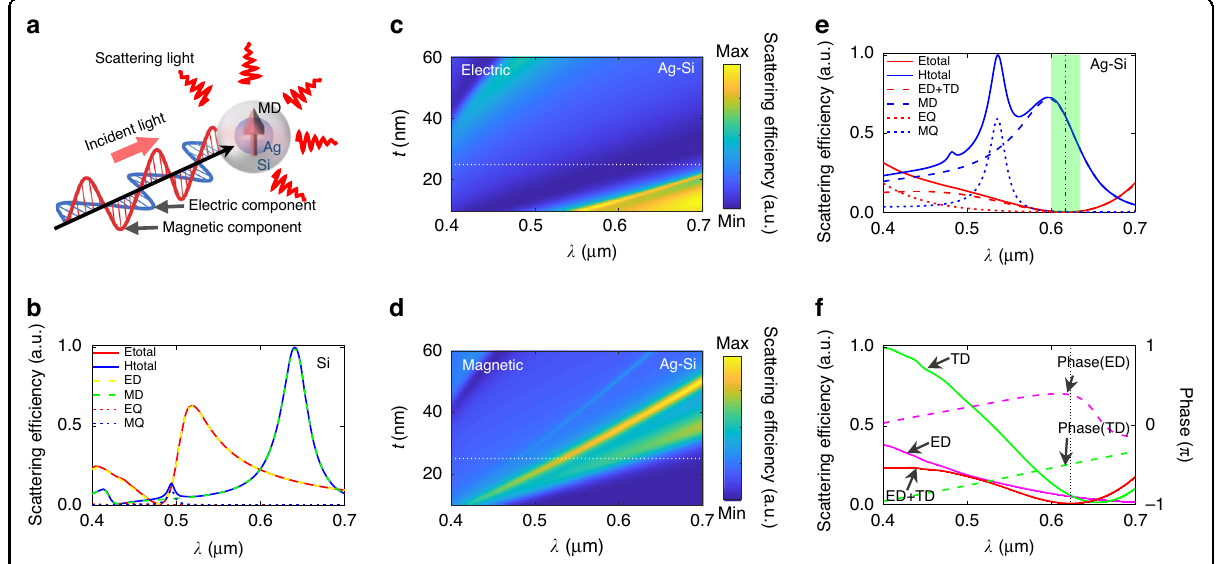
Fig. 1 Design of an anapole probe exhibiting a pure magnetic response. a Schematic of the Ag core-Si shell nanosphere displaying a pure magnetic dipole with no electric response, b typical spectrum of a pure Si-nanosphere of size 160 nm, for the purpose of comparison — the spectral overlap between the electric dipole and magnetic dipole modes hinders the realization of a pure magnetic dipole scatter, c , d electric and magnetic scattering spectra of the core-shell nanosphere when varying the thickness ( t ) of the outer Si shell (its inner Ag core is fi xed at 100 nm), e spectra of an optimized nanoparticle under incident light of wavelength 633 nm — the thickness of the outer Si shell equals 25 nm (marked as white dotted lines in c , d ), and f spectra of the decomposed electric dipole and toroidal dipole modes including both the magnitude and phase information. The anapole mode at ~617 nm arises through the destructive interference of the electric dipole and toroidal dipole modes. ED electric dipole; MD magnetic dipole; EQ electric quadrupole; MQ magnetic quadrupole; TD toroidal